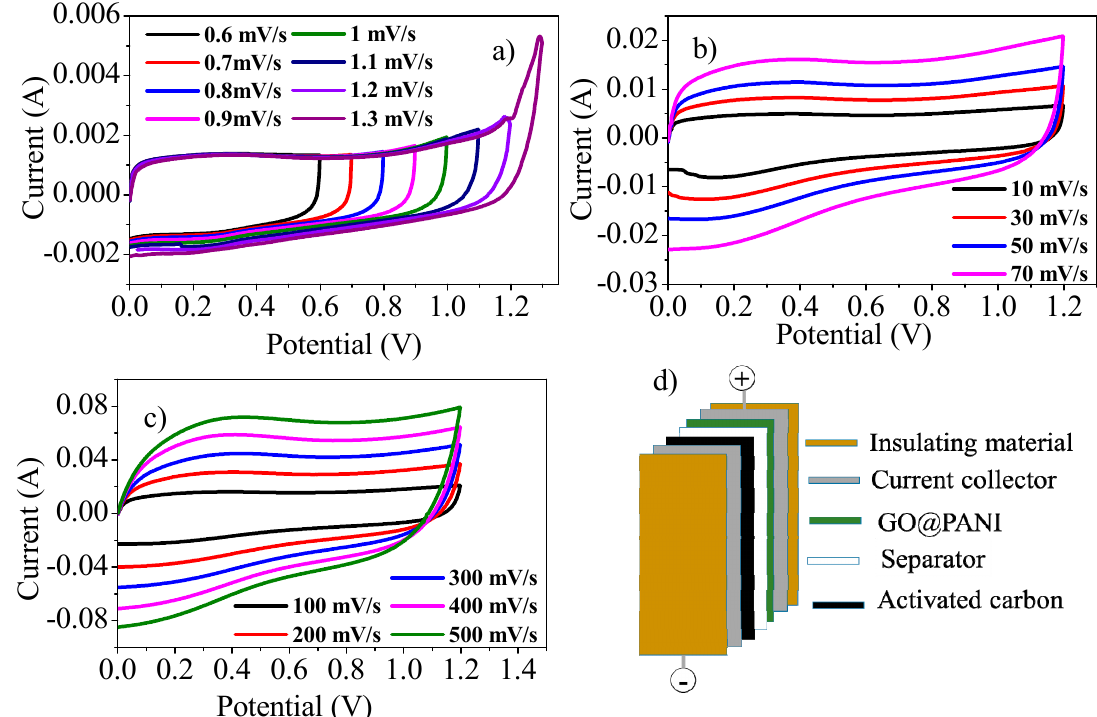
Figure 4. CVs of asymmetric device ( a ) at different potential ranges. ( b ) At various lower scan rates ranging from 10–70 mV/s and ( c ) at numerous higher scan rates ranging from 100–500 mV/s. ( d ) Configuration of asymmetric assembly.